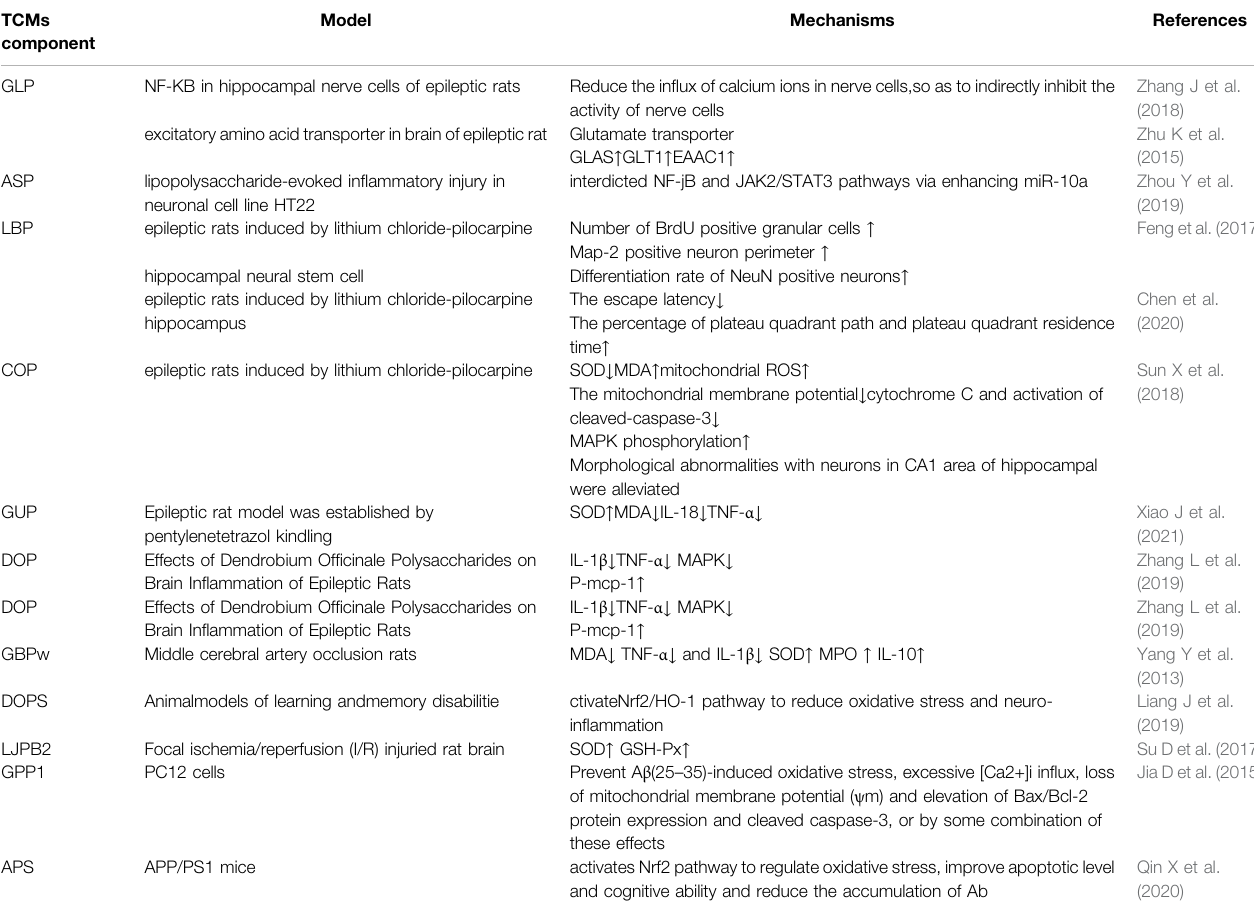
TABLE 1 | Components from TCMs and their effects and cell culture or animal models. TCMs